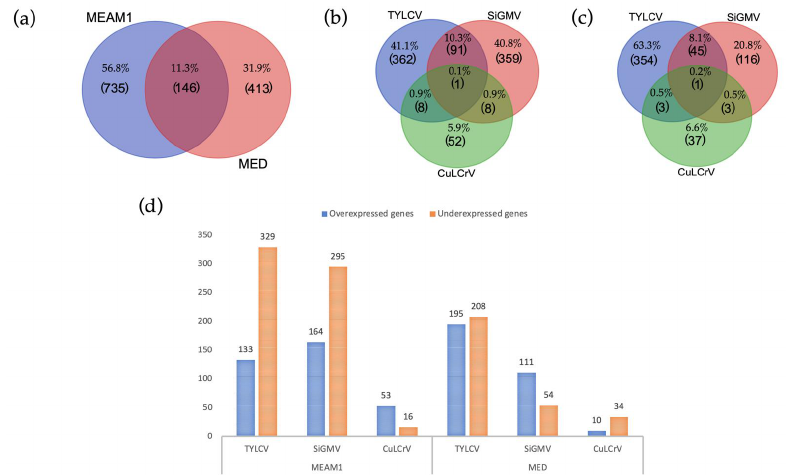
Figure 1. Differentially expressed genes (DEGs) in Bemisia tabaci Middle East-Asia Minor 1 (MEAM1) and Mediterranean (MED) adults provided with an acquisition access period of 72 h on TYLCV-infected versus non-infected tomato plants, SiGMV-infected versus non-infected prickly sida plants, or CuLCrV-infected versus non-infected squash plants: ( a ) Normalized Venn diagram showing unique and common DEGs in B . tabaci MEAM1 and MED adults after the acquisition of TYLCV, SiGMV, or CuLCrV; ( b ) Normalized Venn diagram showing unique and common DEGs in B . tabaci MEAM1 adults after the acquisition of TYLCV, SiGMV, or CuLCrV; ( c ) Normalized Venn